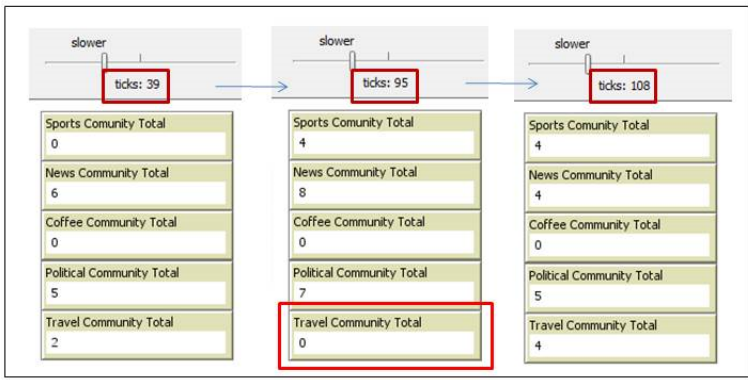
Figure 11. Disappearance of travel community.